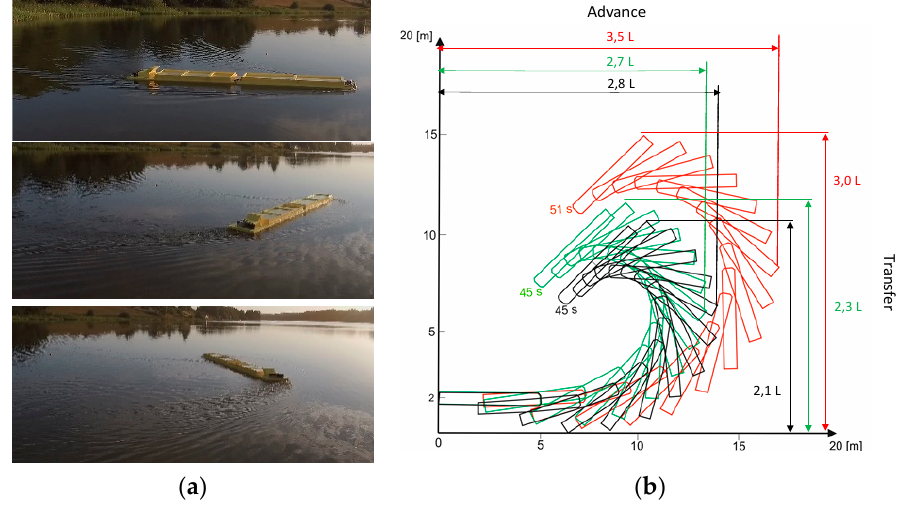
Figure 8. Turning circle of push train model: ( a ) turning circle trial with use of bow RCs; ( b ) maneuvering space of the model using bow RCs (red), stern rudders and bow RCs (green), stern rudders, bow RCs, and dynamical coupling system (black) [1]; L—model length.